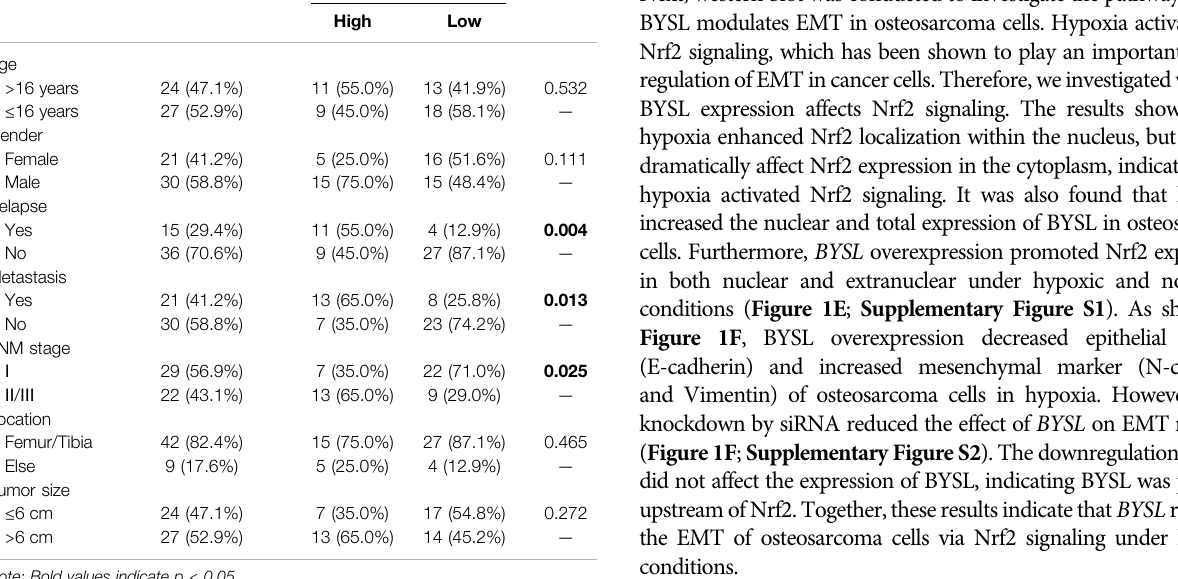
TABLE 1 | Associations between clinicopathological characteristics and BYSL expression in patients with osteosarcoma. Variable Number of patients BYSL expression p Value